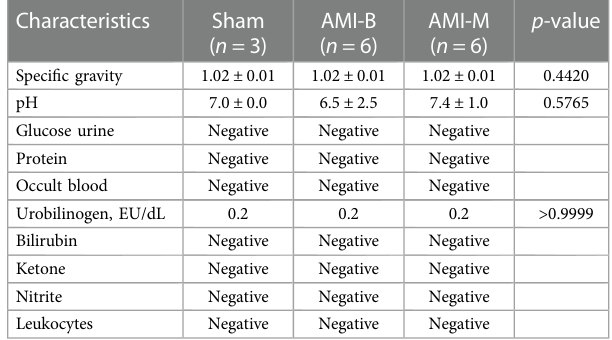
TABLE 6 Urine examination for three groups at 5 months after AMI induction. Characteristics